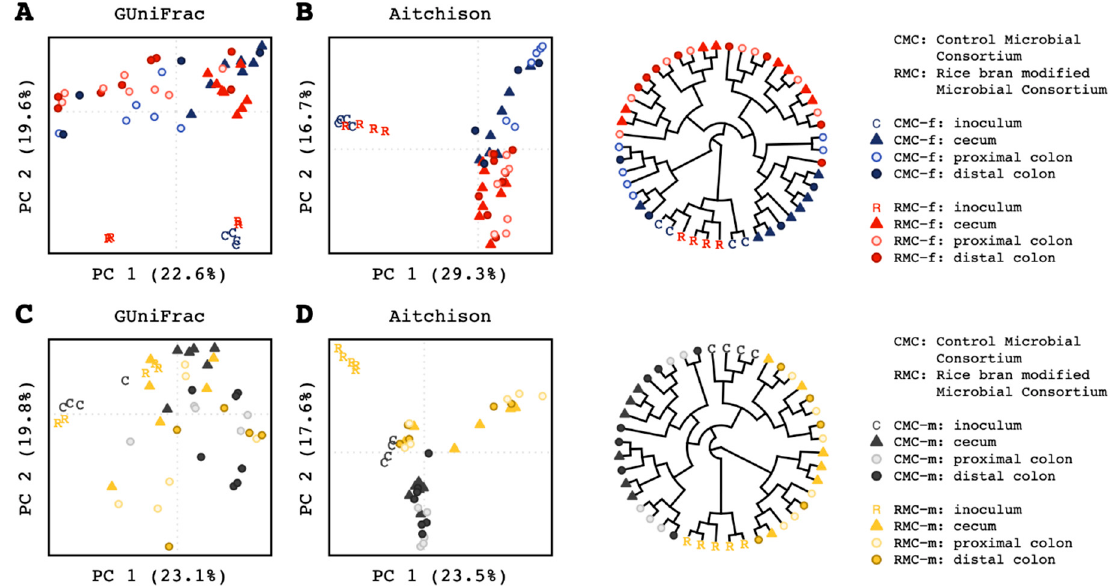
Figure 2. Human control and rice bran modified microbial consortia (CMC and RMC inoculum) compared to murine cecum and colon (proximal and distal) microbiota composition. ( A ) Principal Coordinates Analysis of generalized UniFrac distances for mice colonized with consortia derived from the human female. ( B )Principal Components Analysis (left) and Ward D2 hierarchical clustering (right) of Aitchison distances for mice colonized with consortia derived from the human female. ( C ) Principal Coordinates Analysis of generalized UniFrac distances for mice colonized with consortia derived from the human males (CMC ‐ m/RMC ‐ m). ( D ) Principal Components Analysis (left) and Ward D2 hierarchical clustering (right) of Aitchison distances for mice colonized with consortia derived from the human male. ( A – D )letters indicate human stool inoculum samples, shapes distinguish murine sample type, and colors denote sex of donor (see key for female: red/blue and male: yellow/black).